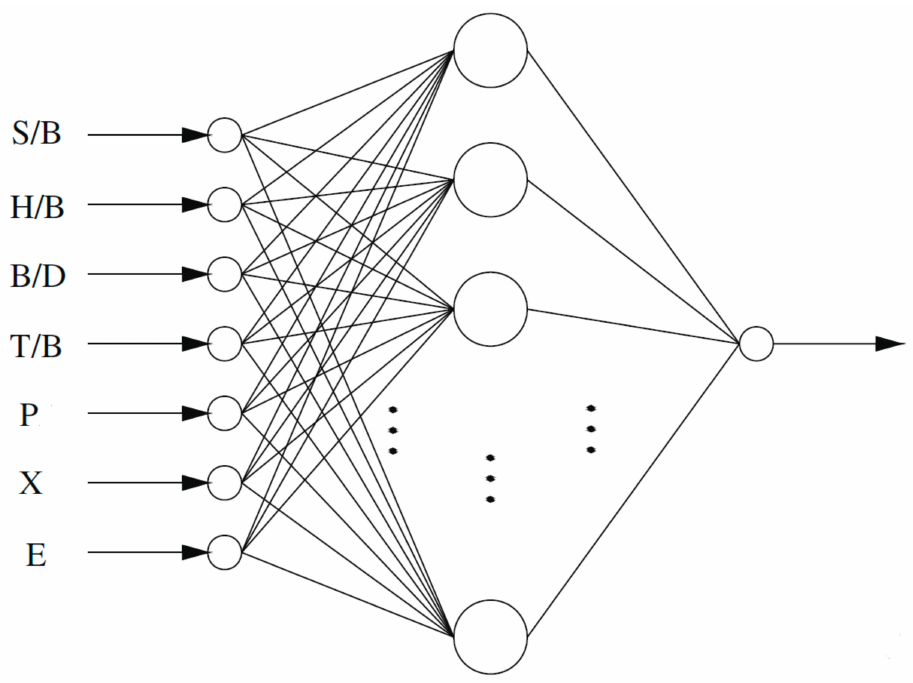
Figure 8. Using seven neurons in the input layer to build the initial ANN structure